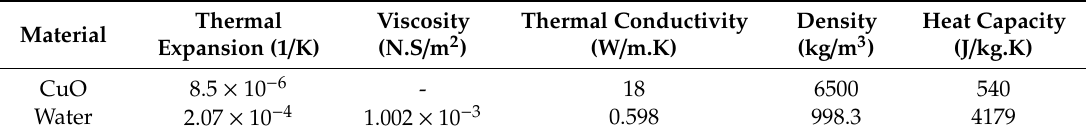
Table 1. Thermophysical properties of copper oxide nanoparticles (NPs) and water at the ambient conditions